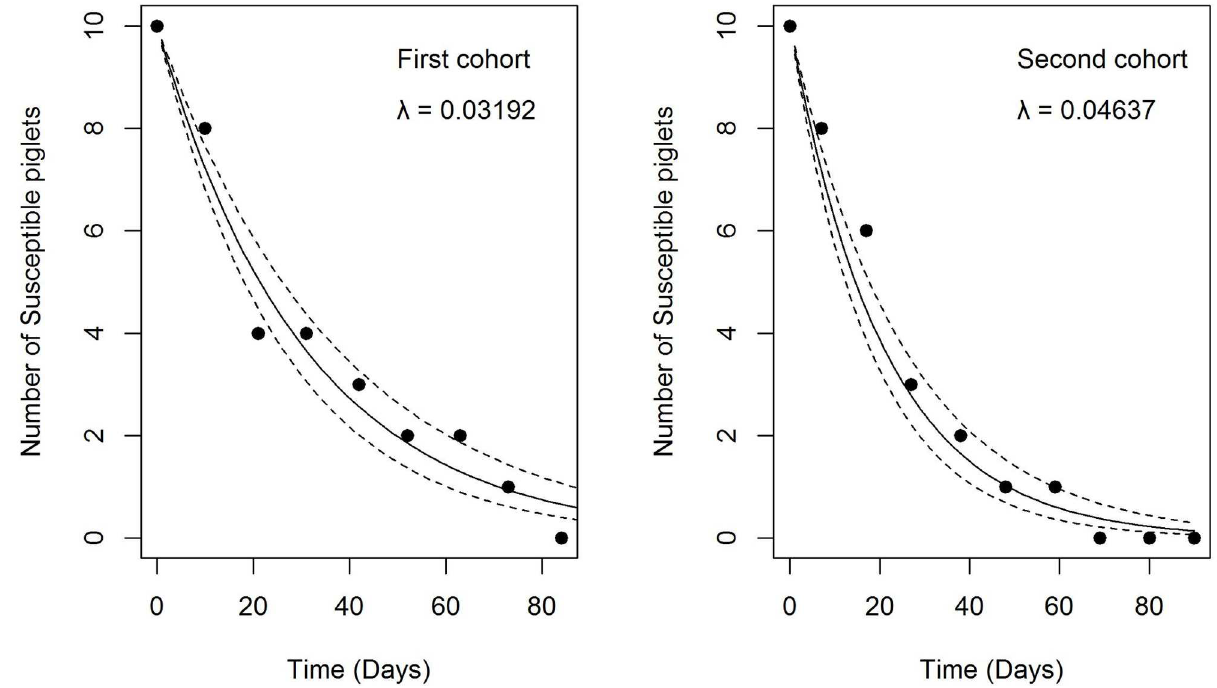
Fig 3. Estimated FOI ( λ ) for period 1 (n = 10 pigs) and period 2 (n = 10 pigs). The numberof susceptiblepigs in our sentinelcohorts is shown as points, the fitted model is shown as a solid line with standard deviationas